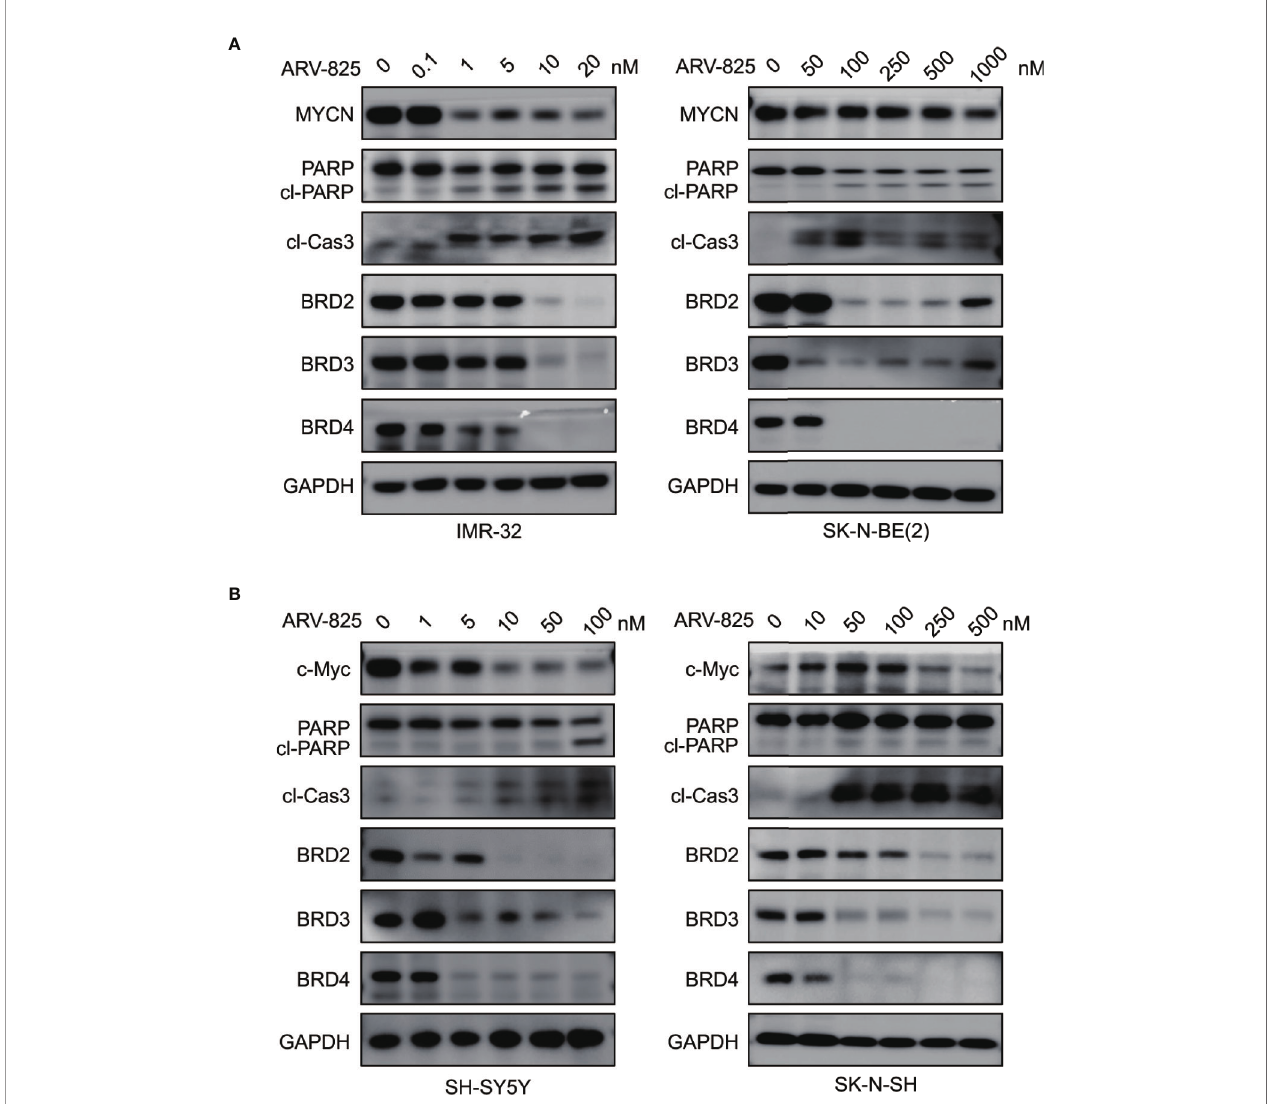
FIGURE 6 | ARV-825 degrades BET proteins and suppresses MYCN or c-Myc expression. (A) Western blot analysis showed that ARV-825 induced BET proteins degradation, PARP and Caspase3 cleavage, and MYCN protein reduction in MYCN -ampli fi ed NB cells [left: IMR-32 cells; right: SK-N-BE(2) cells]. (B) Western blot analysis showed that ARV-825 induced BET proteins degradation, PARP and Caspase3 cleavage, and c-Myc protein reduction in MYCN non-ampli fi ed NB cells (left: SH-SY5Y cells; right: SK-N-SH